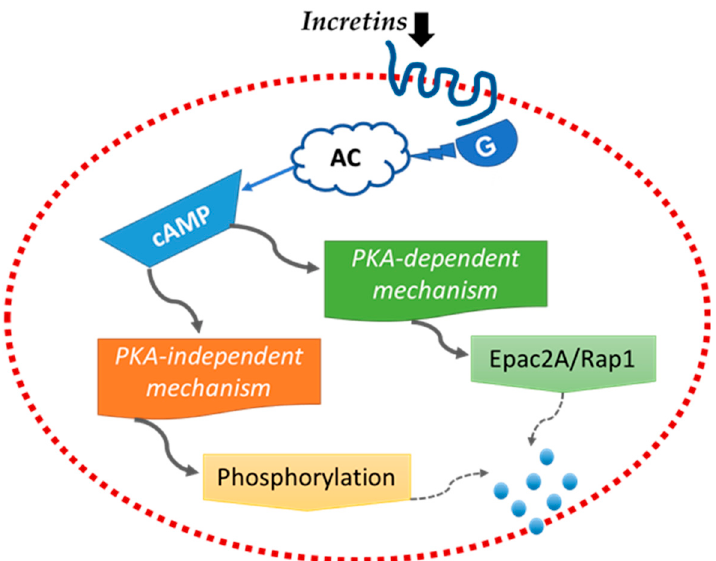
Figure 7. Incretins’ mechanism and signaling in the b-cells of pancreas. Incretins induce the cAMP signaling pathway through G protein-coupled receptors. The cAMP signaling is divided into two different Protein Kinase A pathways: the dependent mechanism activates the exocytosis of insulin, while the independent regulates the amount of insulin granules that prepared for exocytosis.